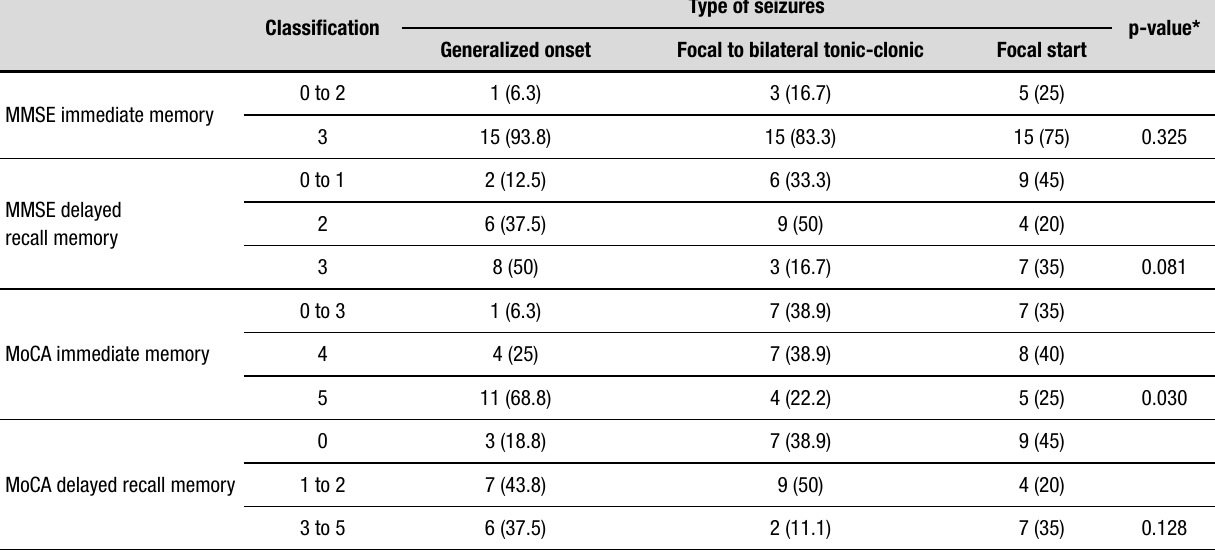
Table 5. Type of epileptic seizure × immediate memory and delayed recall memory